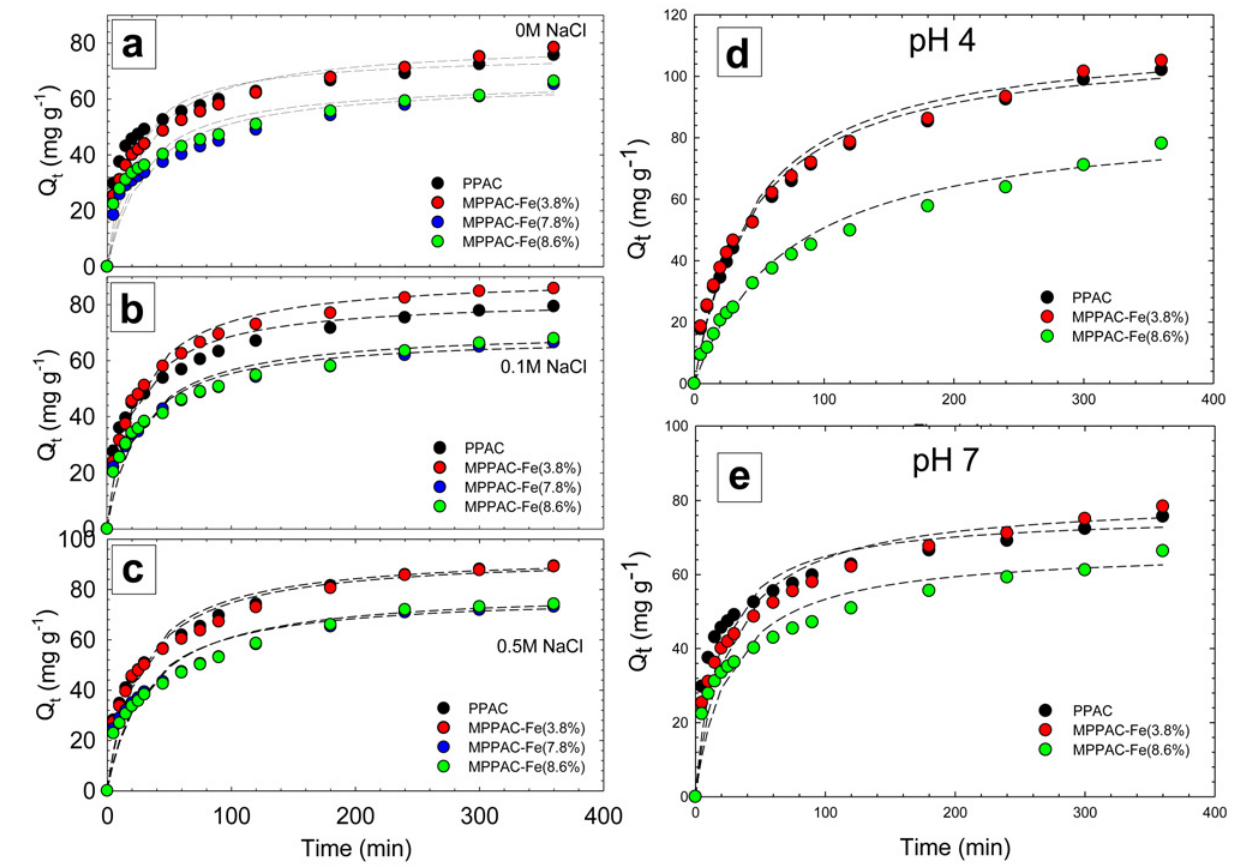
Fig 4. (a-c) Adsorption kinetics of IBP by various media at pH 7.0 at different ionic strength (0 ~ 0.5 M) (fit lines obtained from Pseudo-second order kinetic model), kinetics of IBP uptake by media at pH 4 (d) and 7 (e) at 0.1 M of ionic